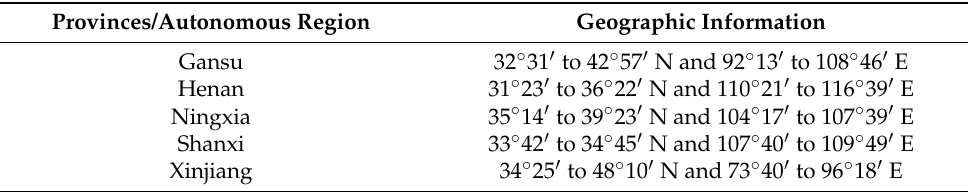
Table 1. The geographic information of the provinces/autonomous regions from which samples were